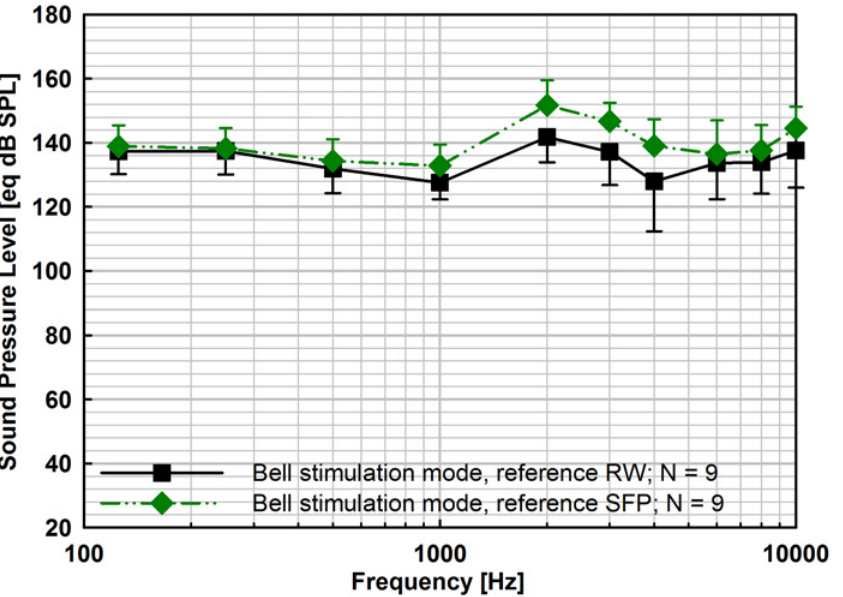
Fig 10. Equivalent sound pressure levels obtained by oval window stimulation with the Bell prosthesis using either the RW displacements ( ■ ) or the SFP displacements ( ♦ ) in response to sound and actuator as reference. Mean values and standard deviations (error bars) of eq. sound pressure level are shown for nominally 1 V rms actuator input.